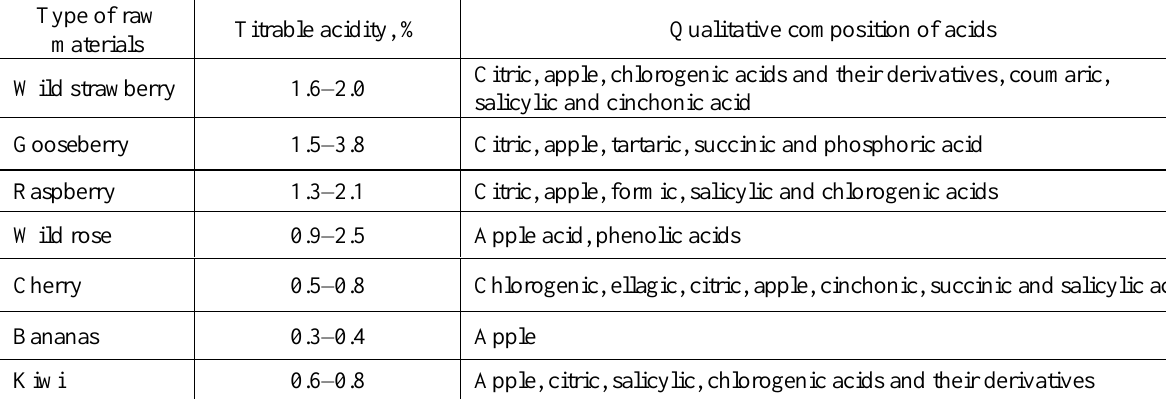
Table 3. Content of vitamins in fruits and berries, mg / 100g